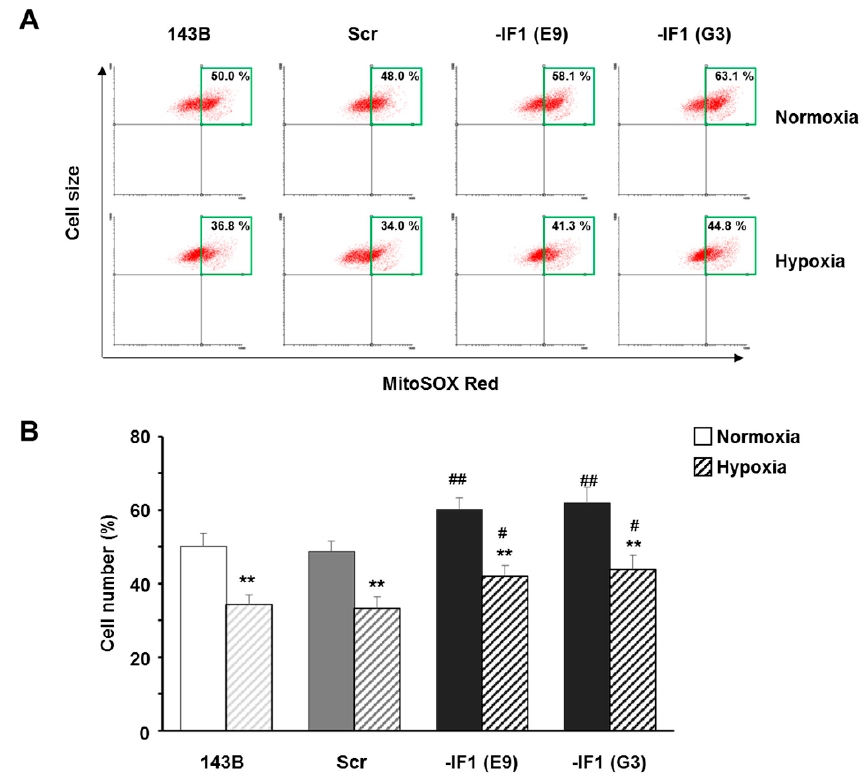
Figure 5. IF 1 affects superoxide anion production in osteosarcoma cells grown under either normoxia or hypoxia. ( A ) Representative top right quadrant analysis and ( B ) bars graph of superoxide anion levels measured in MitoSOX Red-loaded parental (143B), scrambled (Scr) and IF 1 -silenced (E9 and G3) cells cultured in either normoxia or hypoxia (0.5% O 2 ) for 24 h. Data are means ± SD of four independent experiments. ** p ≤ 0.01, indicates the statistical significance of data compared to normoxia; # p ≤ 0.05 and ## p ≤ 0.01, indicate the statistical significance of data compared to controls.